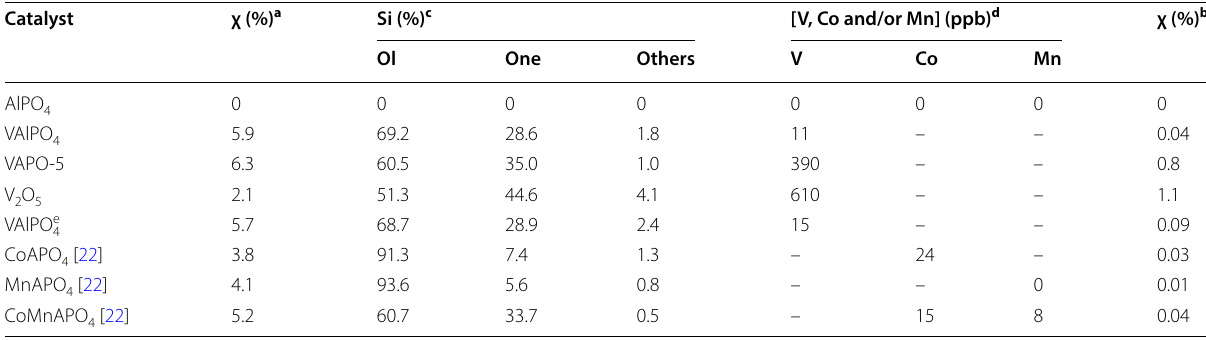
berlinite and VAPO-5 molecular 4